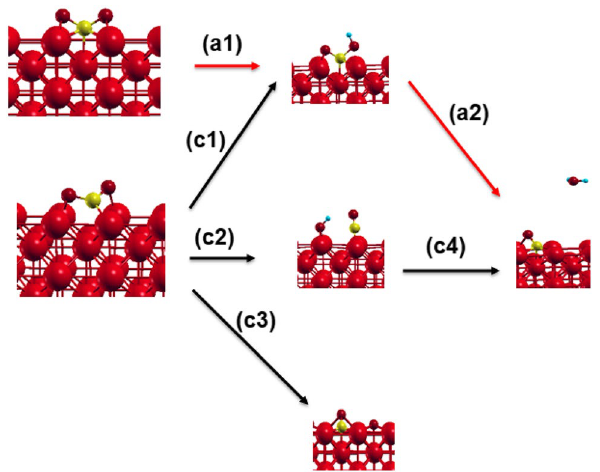
Fig. 5 Energy profile diagram for the conversion of CO